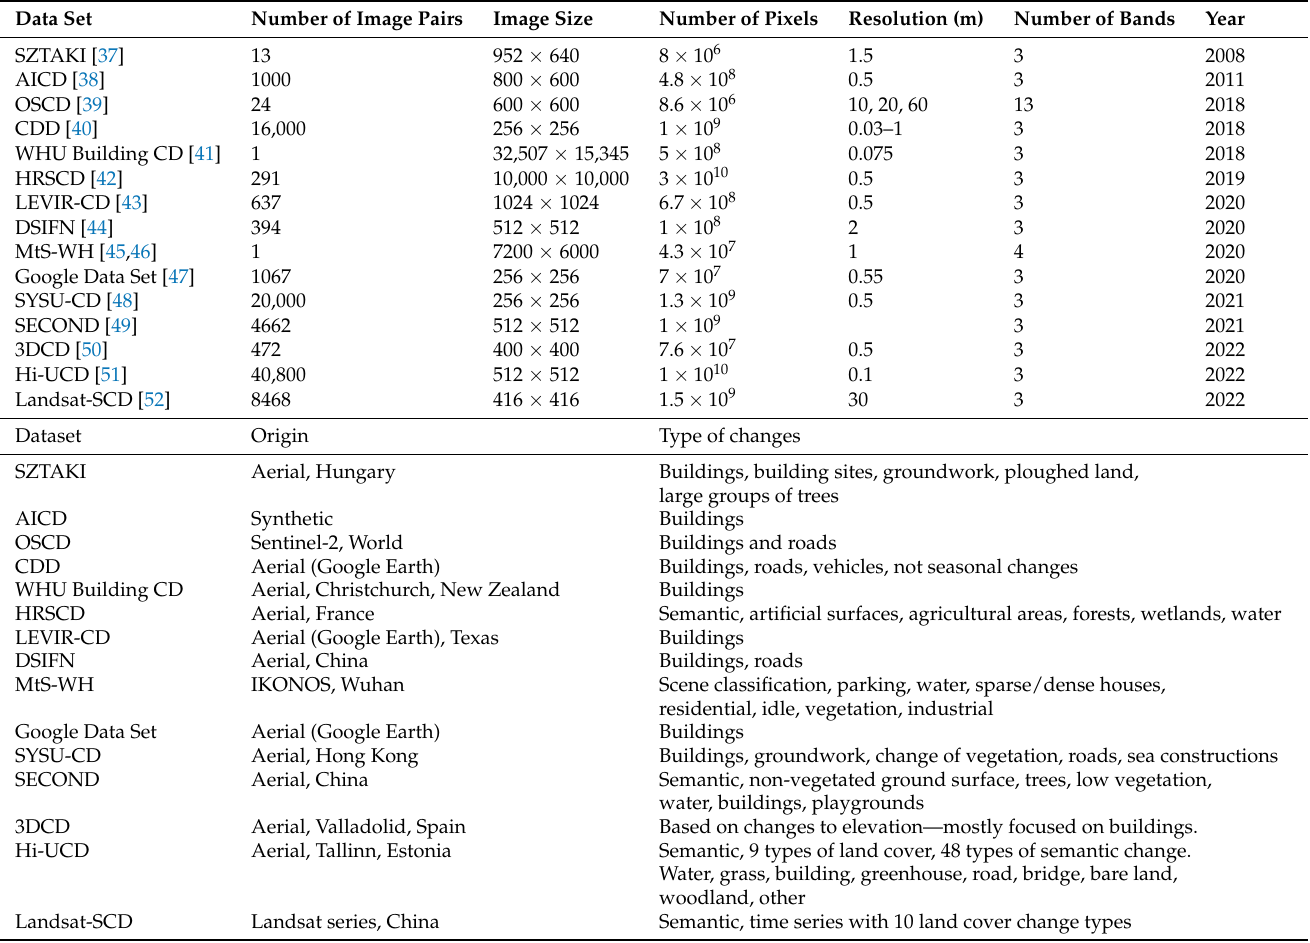
Openly available bitemporal multispectral remote sensing datasets annotated for change